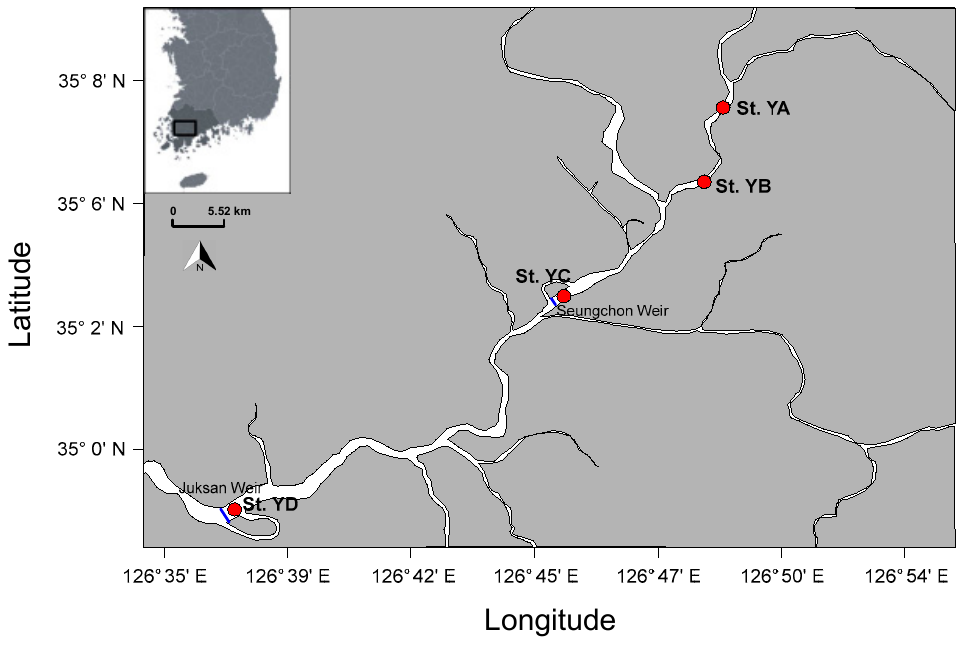
Figure 1. The sampling stations situated far from the weirs (YA, YB) and near the weirs (YC, YD) in the upper Youngsan River estuary, South Korea.